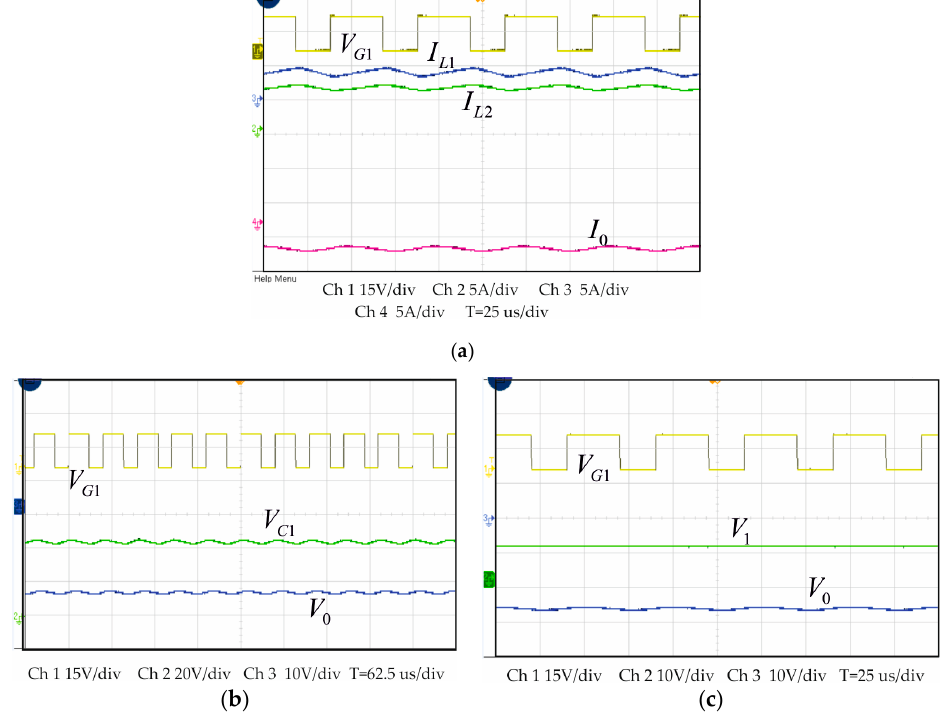
Figure 14. Various voltage and current measurements from experiments during Mode 1 with source 1 (Boost mode): ( a ) Gate signal, inductor currents through L 1 , L 2 and Load current (CH 1–4); ( b ) Gate signal and capacitor voltages across C 1 and C 2 (CH 1–3); ( c ) Gate signal, source voltages and output voltage (CH 1–3).